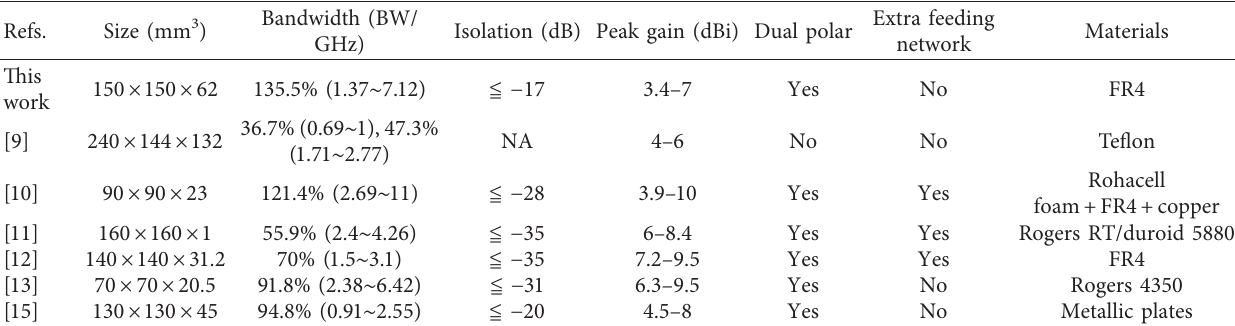
Table 4: Comparison of different antennas.